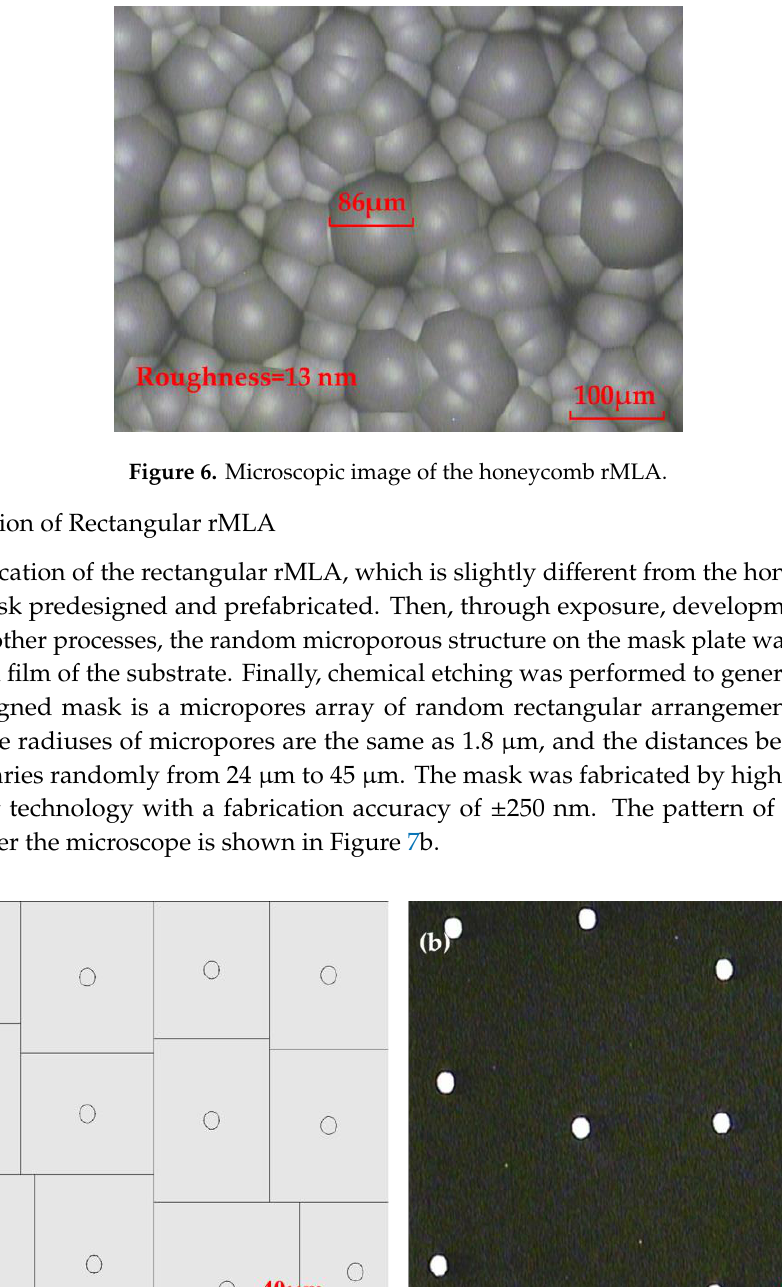
Figure 5. Fabrication schematic of honeycomb rMLA: ( a ) chromium plating; ( b ) corroded chromium film; and ( c ) honeycomb rMLA obtained by chemical etching.